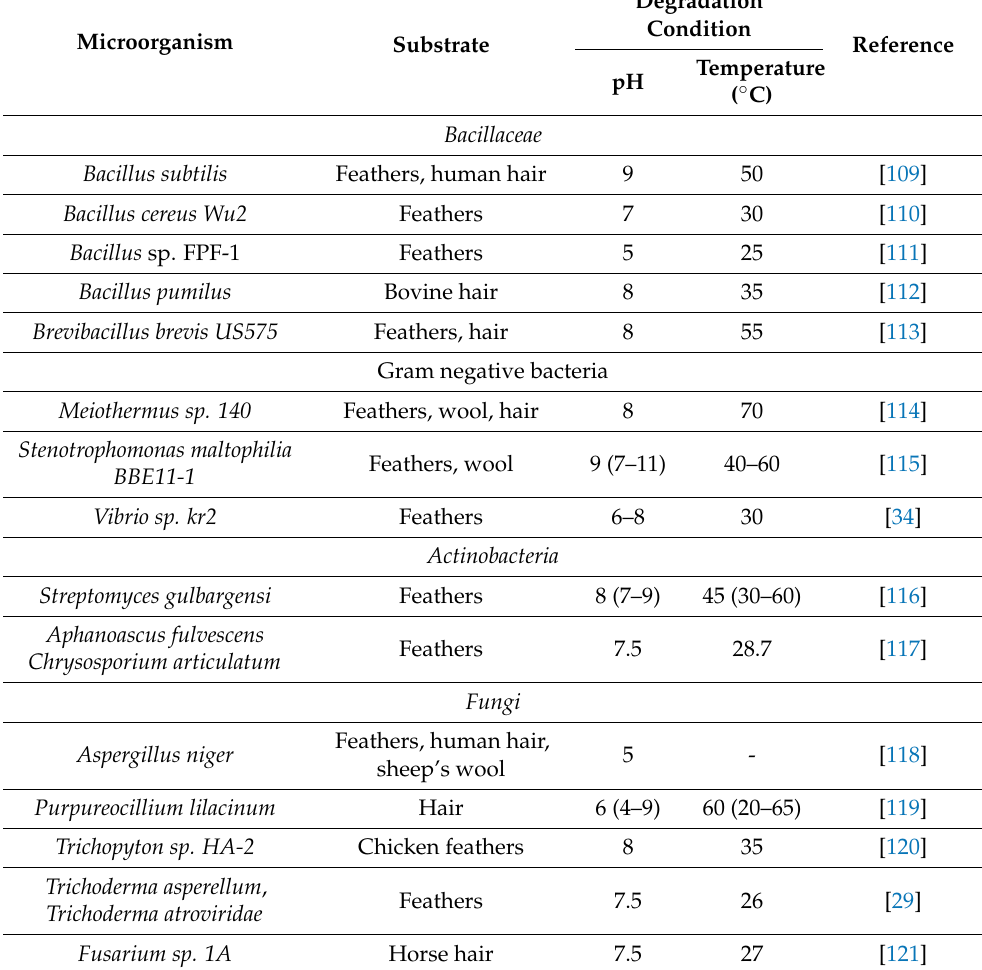
Table 7. Keratinolytic microorganisms and degradation conditions of keratin substrates.